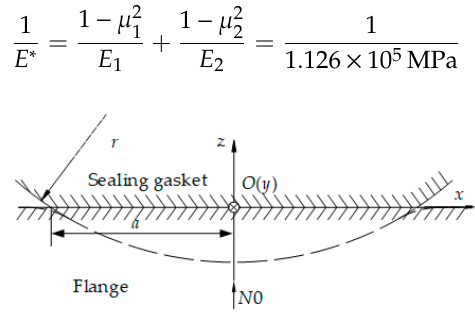
Figure 4. Contact principle diagram of the sealing gasket. r is the radius of the sealing sphere; a is the sealing half-width.